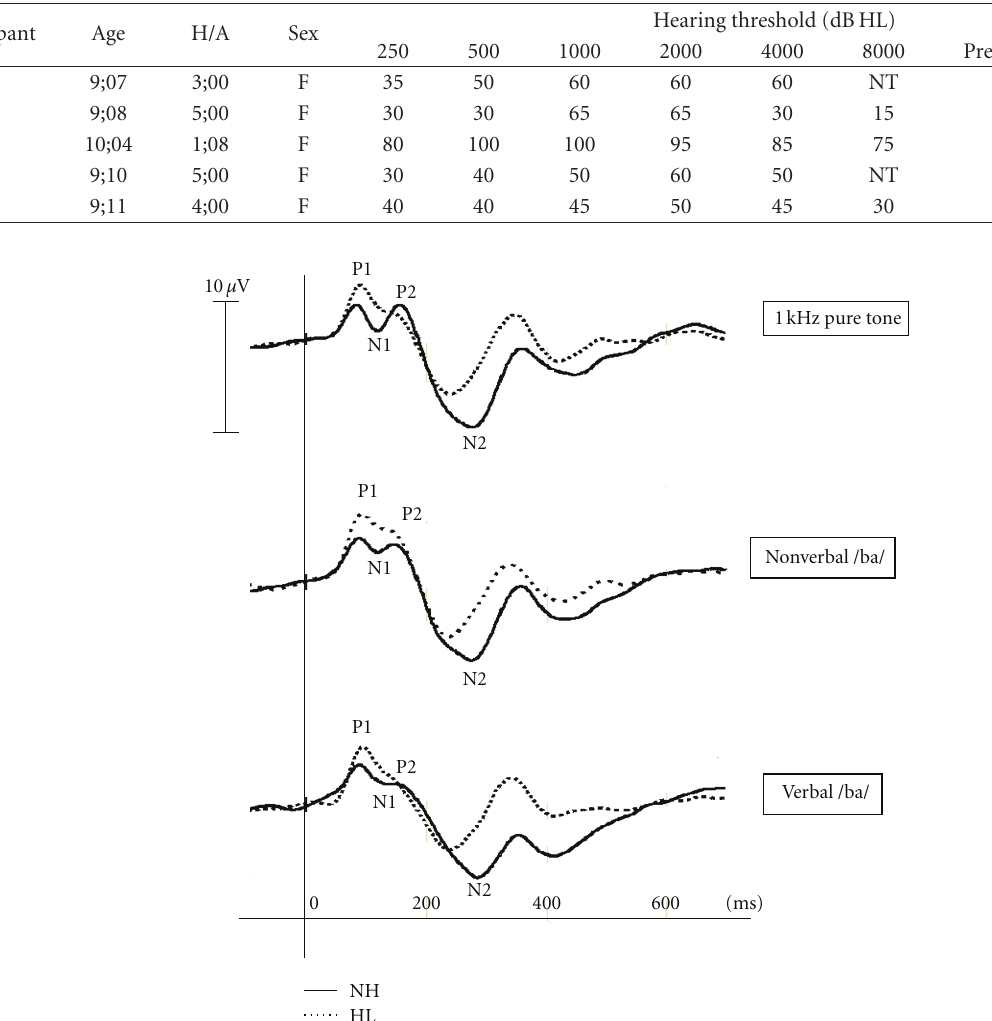
Figure 1: Waveforms recorded at FCz electrode from five children with normal hearing—NH (solid line) and five with hearing loss—HL (dashed line) with 1kHz pure tone (top), nonverbal /ba/ (middle) and /ba/ (bottom)